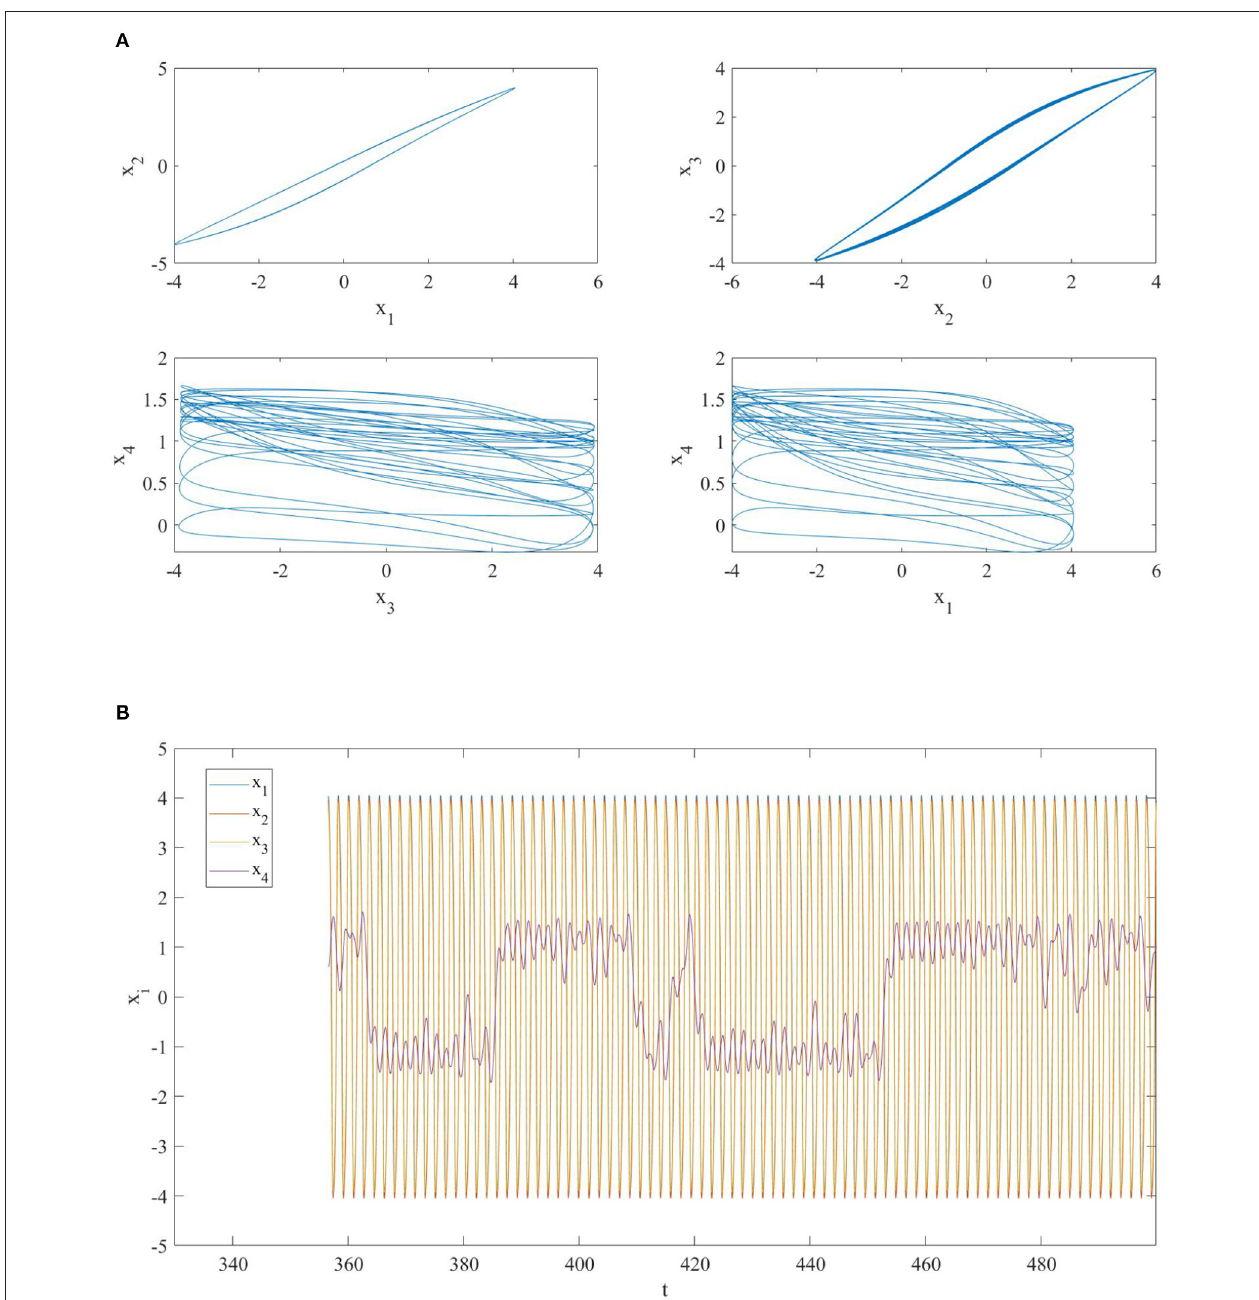
1 1ϕ 0 = 0.15, R 1,3 1 1ϕ 0 = − 0.075, R 1,3